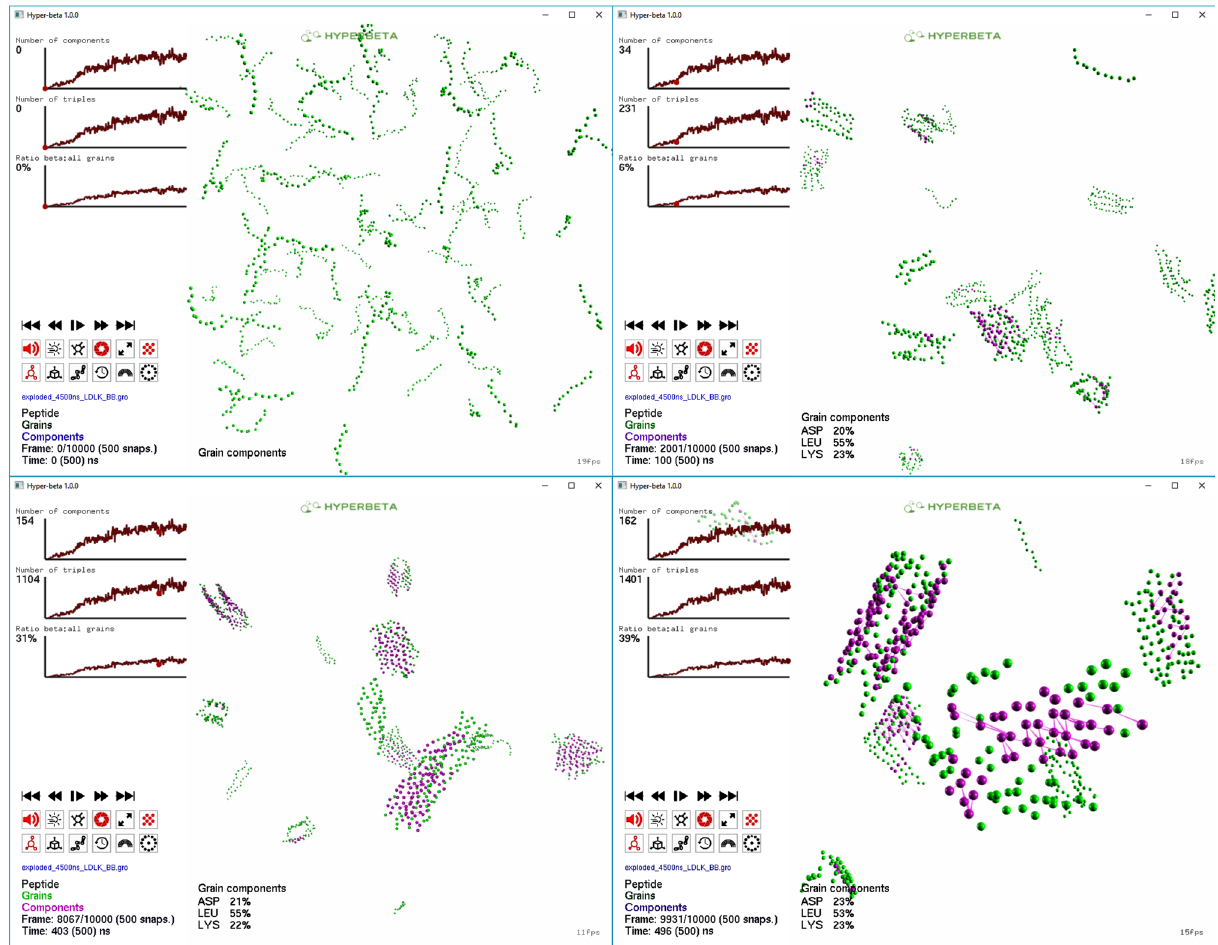
Figure 3. Analysis of (LDLK) 3 CG-MD trajectory simulation. Grain components refer to the type of grains belonging to the different β -sheets. The composition of the components remains constant, resulting from the alignment of Aspartic acid, Lysine and Leucine